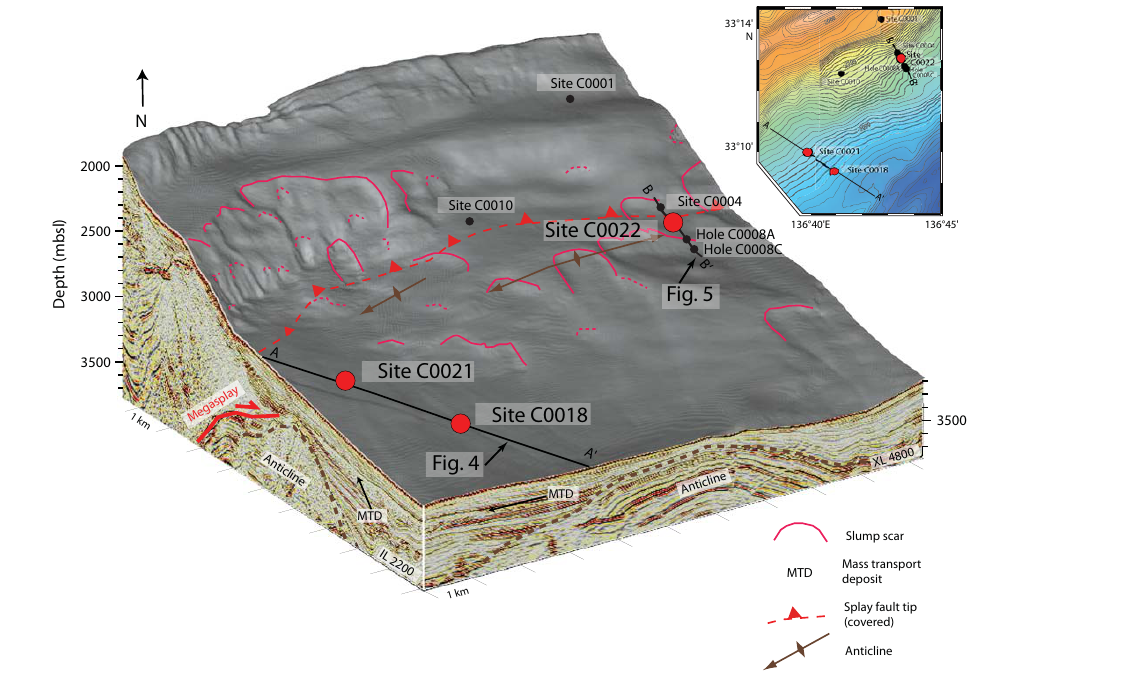
Figure 3. Detailed surface morphology and structure of the slope basin at the footwall of the splay fault (Strasser et al., 2011) showing Expedition 338 sites (red) in relation to NanTroSEIZE Stage 1 and 2 sites (black). Solid black lines = locations of seismic lines A–A 0